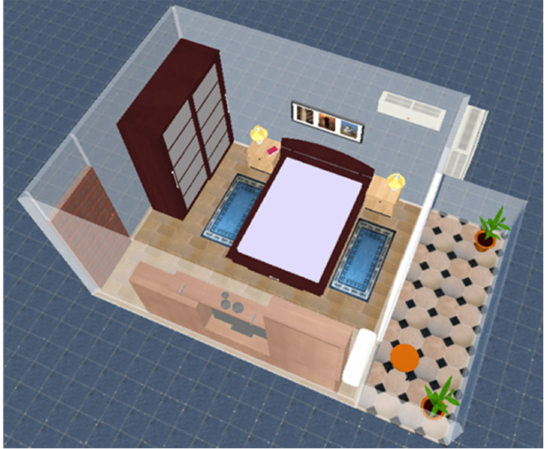
Figure 2. 3D representation of the room